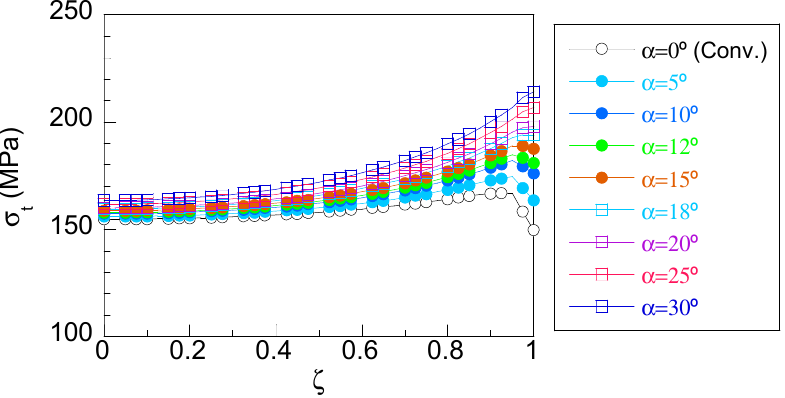
Figure 8. Hub axial distribution of the tangential stress at the shaft–hub interface. With regard to the distribution of the von Mises stress for a conventional hub (blank circles in Figure 9), the stress softly increased in the zone out of the stress concentration (0 < ζ < 0.8) and close to the hub edge, the von Mises stress heavily increased, reaching a maximum value at the hub edge.